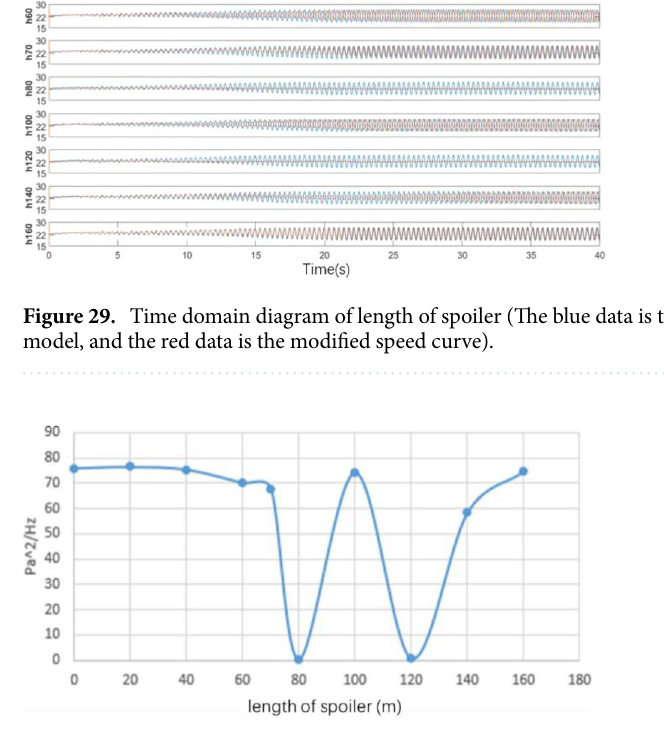
Figure 30. Power spectral density function